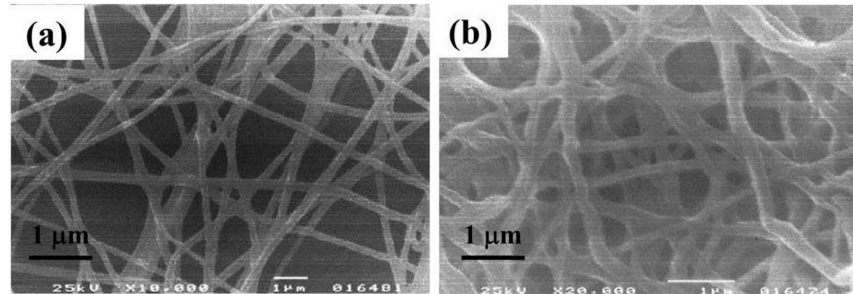
Figure 5. SEM images of cellulose nanofibers at 3% concentration in N -methylmorpholine N -oxide (NMMO) ( a ) normal cellulose fibers ( b ) spaghetti-like cellulose nanofibers [93]. Reproduced with permission from ref. [93]. John Wiley and Sons,